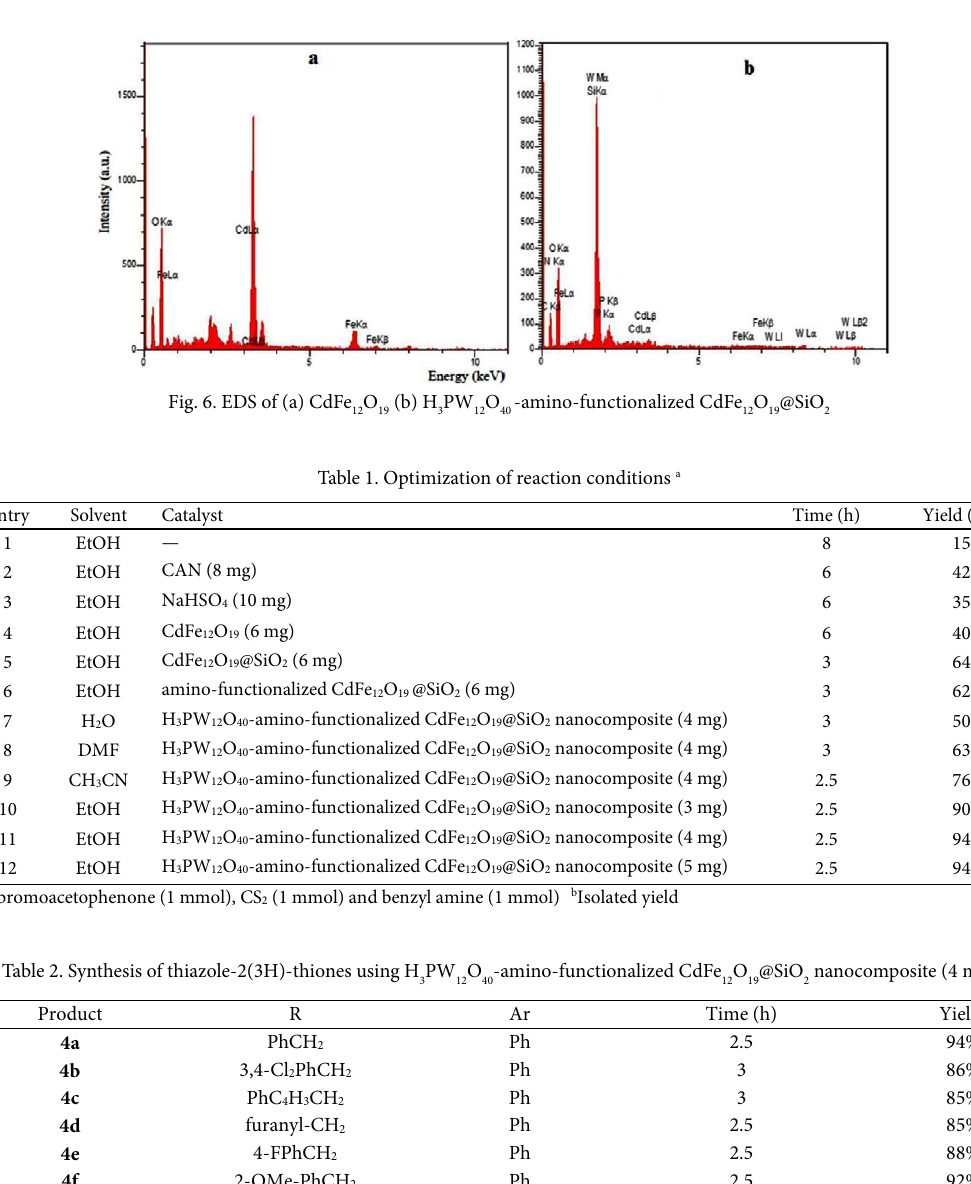
O @SiO nanocomposite (4 12 19 2